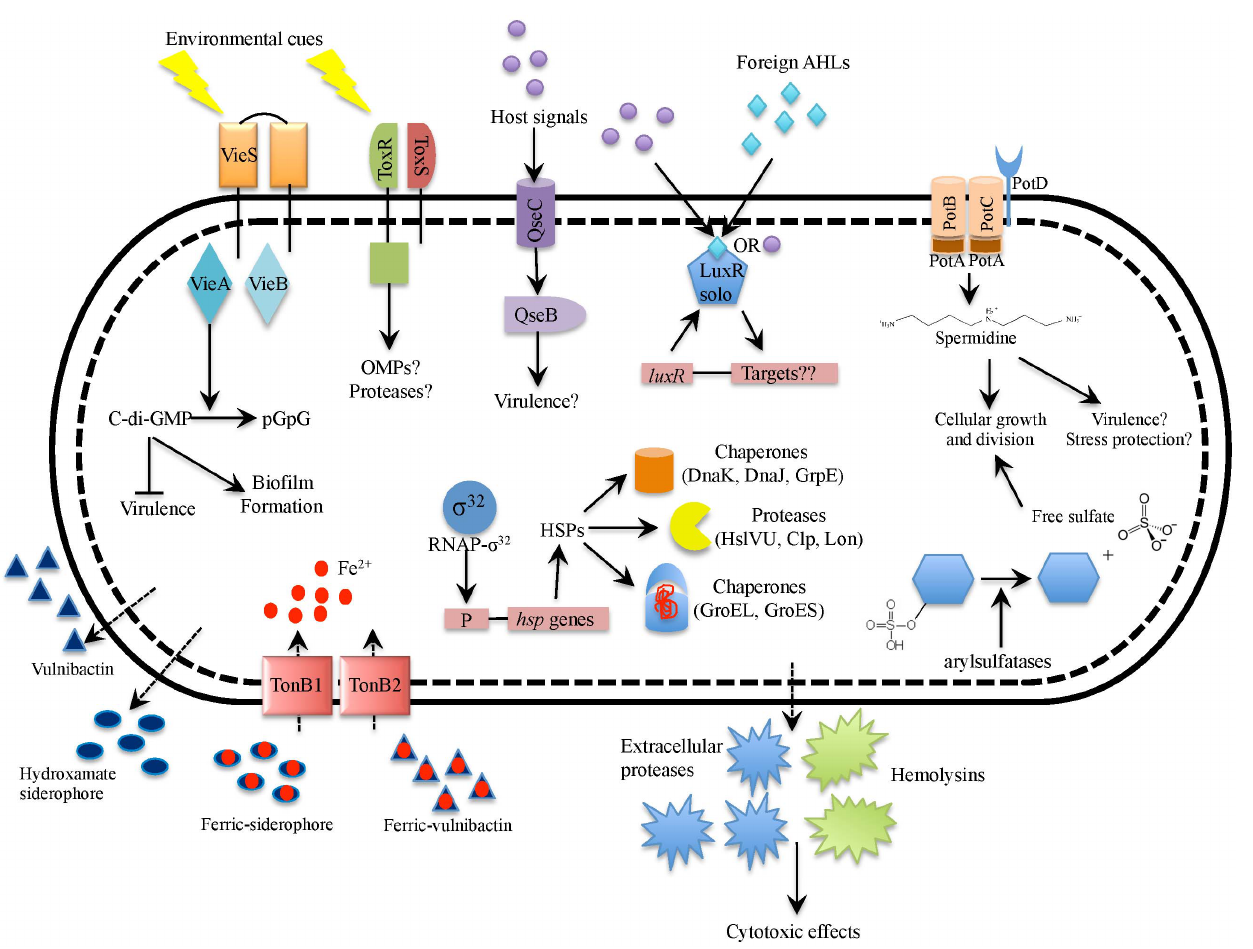
Fig. 6. Diagrammatic summary of genes upregulated in human serum relative to artificial seawater. Depicted in this figure are genes (or sets of genes) upregulated in HS along with the inferred phenotypic outcomes. In this condition, the cell scavenges for nutrients by utilizing processes involved in substrate binding and transport including iron chelators and transport systems (hydroxamate-siderophore, vulnibactin, TonB1, and TonB2), spermidine transport (PotABCD), and sulfate scavenging arylsulfatases. In response to unknown environmental cues, the cell also engages in intracellular signaling using systems such as a two component signal transduction system (VieSA) involved in c-di-GMP signaling, the ToxRS signal transduction system, and a LuxR-family orphan possibly involved in quorum sensing signaling, and the cell possibly senses and responds to host hormones using a two-component signaling system (QseBC) involved in inter-kingdom cross-talk. The cell responds to human body temperature (37 ˚ C) by upregulating genes involved in the heat shock response (sigma factor RpoH, chaperones and proteases). The cell also secretes several putative virulence factors such as cytotoxic hemolysins and extracellular proteases. Note, this diagram is developed based solely on transcriptomic data and further investigation is necessary to establish the proposed model.